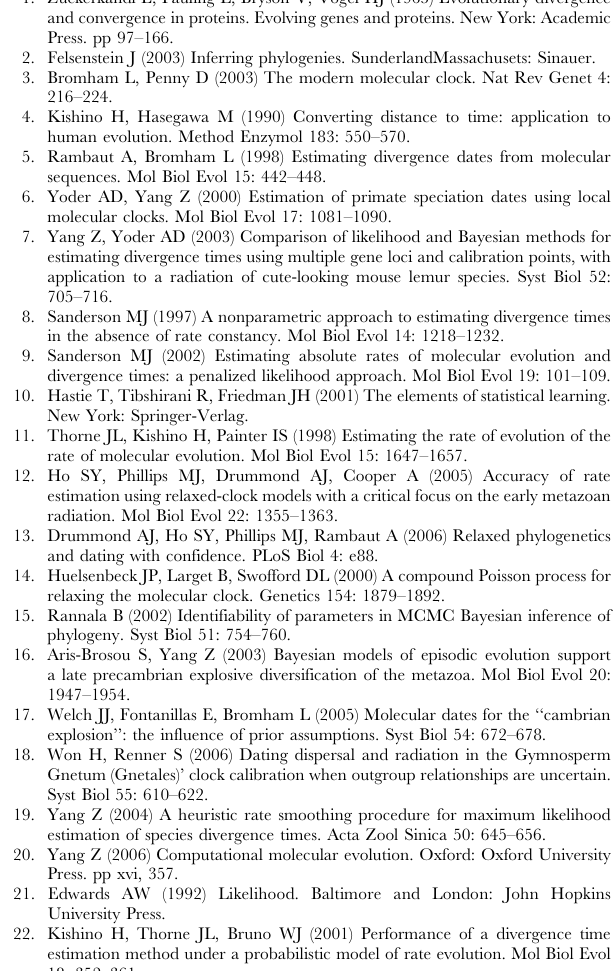
Figure S2 Maximum likelihood estimates of divergence times for the nucleotide data partitioned according to the three codon positions and the estimated local clock models. Times were estimated using k-medoids with the gap statistic, Median Silhouette Splits (MSS) and Hierarchical Ordered Partitioning and Collapsing Hybrid (HOPACH) and are given in million years ago (MYA). Filled circles indicate the seven calibration points on the trees scaled to time (leftmost column); the other trees are scaled to the expected number of substitutions per nucleotide site for the partitions over the three codon